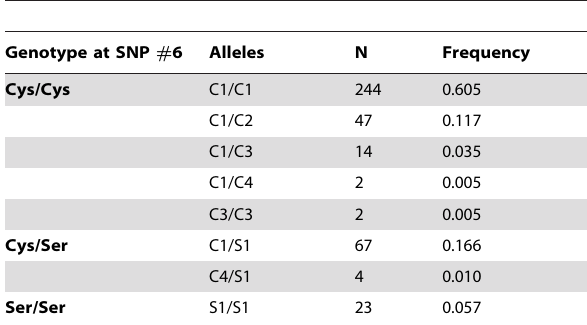
Table 3. Distinct Nv- nfkb genotypes identified and their frequency of